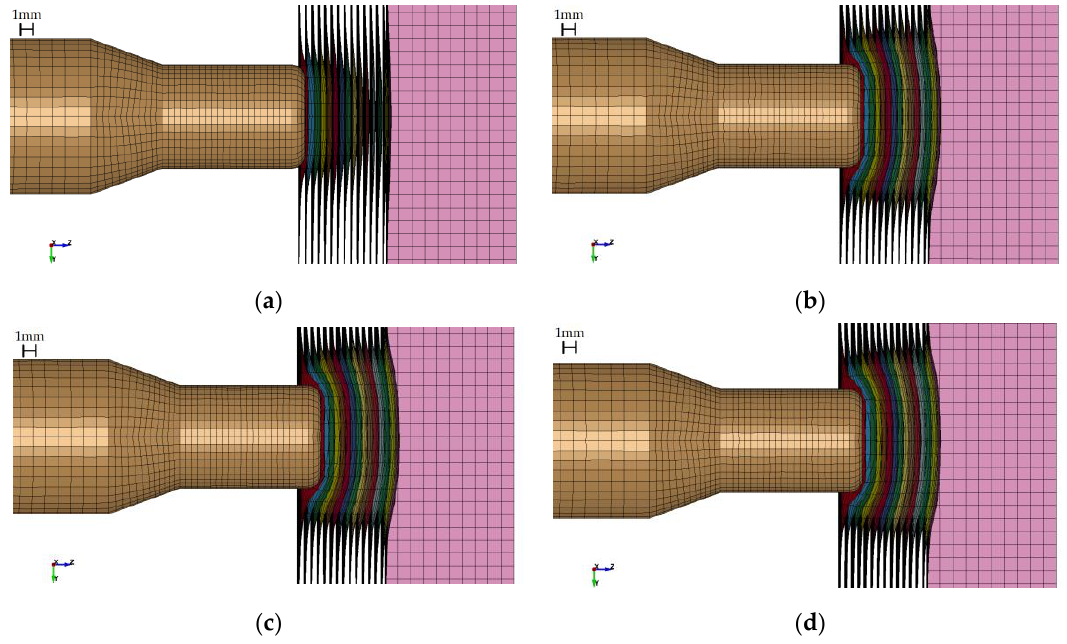
Figure A5. Damage caused by the blunt striker at different instances of the simulation: ( a ) time = 0.05 ms, ( b ) time = 0.1 ms, ( c ) time = 0.12 ms, ( d ) time = 0.15 ms.